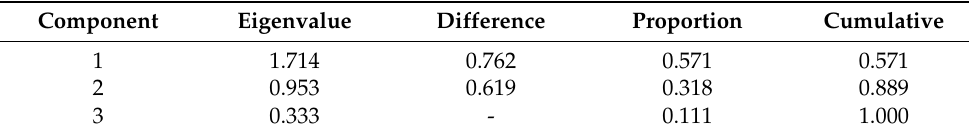
Table 5. Total Variance Explained.